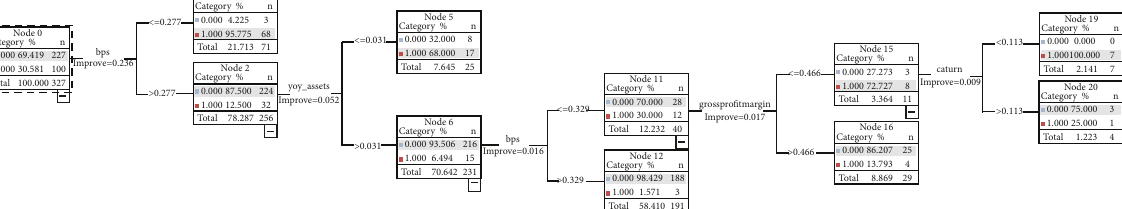
Figure 7: CART decision tree